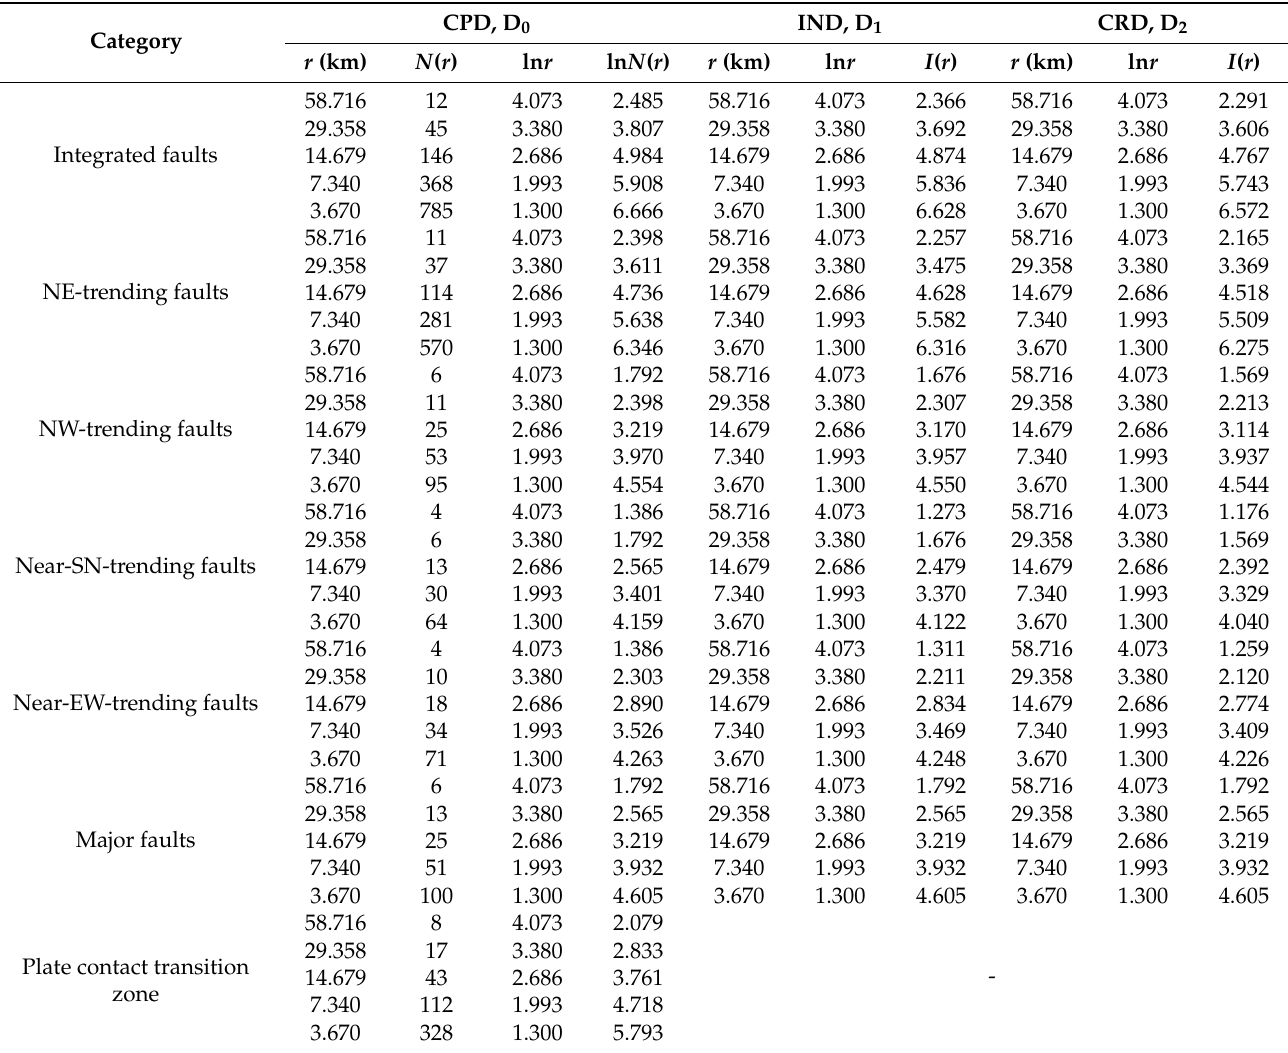
Table 1. Statistical table of calculation parameters of fractal dimensions for fault structures in the eastern Guizhou Pb–Zn metallogenic belt